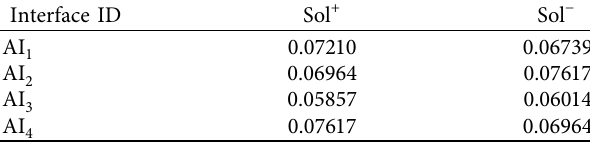
Table 5: Separation distances for interface alternatives.